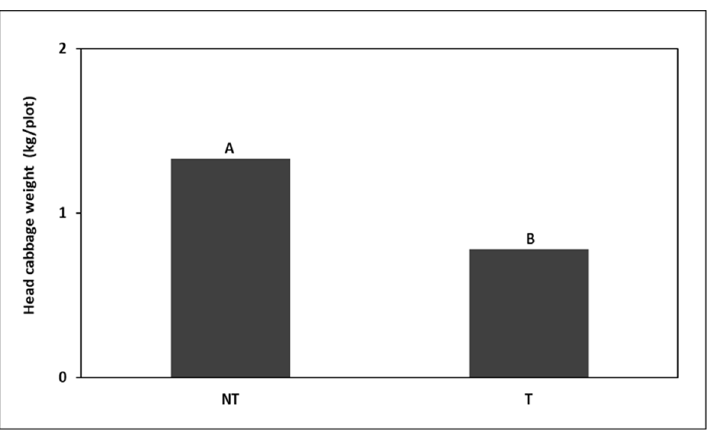
Figure 7. Effect of trap cropping on the productivity of head cabbage. T = trap crop, NT = no trap crop in the Waialua Trial (Trial I). Means followed by the same letters are not different based on analysis of variance.